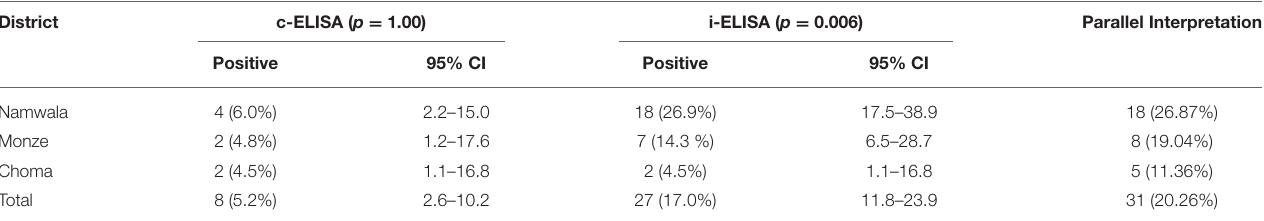
TABLE 2 | Seroprevalence of human anti- brucella antibodies in Southern province by district among herdsmen and abattoir workers using c-ELISA or i-ELISA in parallel interpretation. District c-ELISA ( p = 1.00) i-ELISA ( p = 0.006)